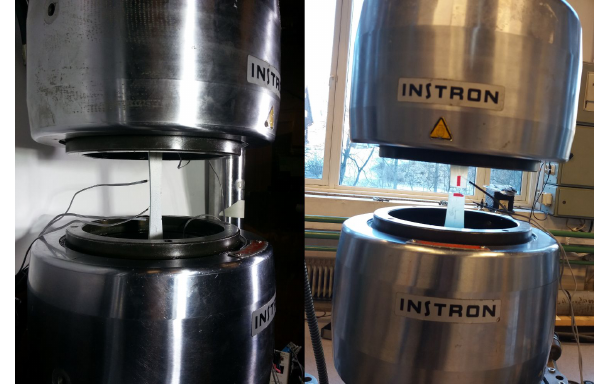
Figure 4: Placement and failure of the specimen in the test machine.